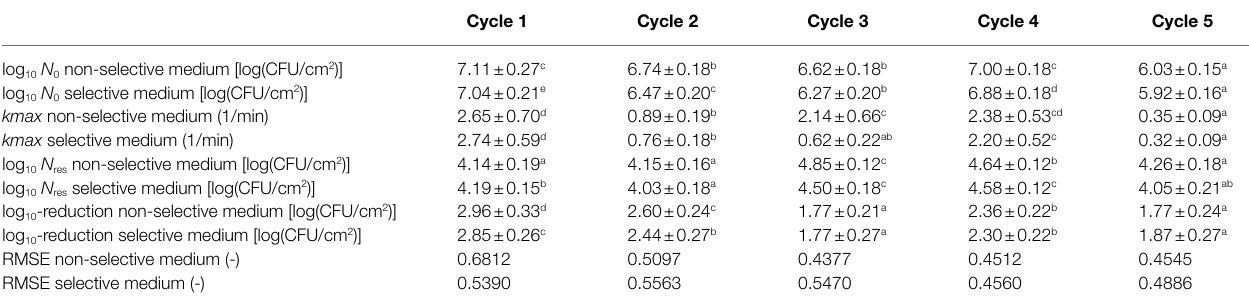
TABLE 1 | Model parameters obtained following CAP treatment of the Listeria monocytogenes model